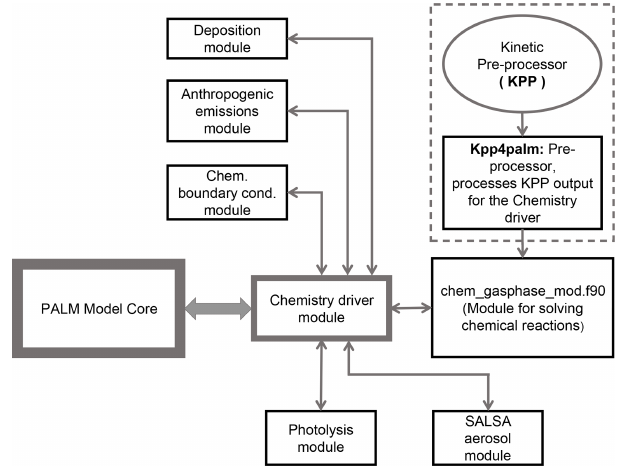
Figure 1. Schematic representation of the chemistry model (PALM- 4U component) of the PALM model system. The arrows show inter- action between the PALM model core, the chemistry driver module and sub-modules. The dashed box indicates the chemical prepro- cessor which generates subroutines to solve chemical